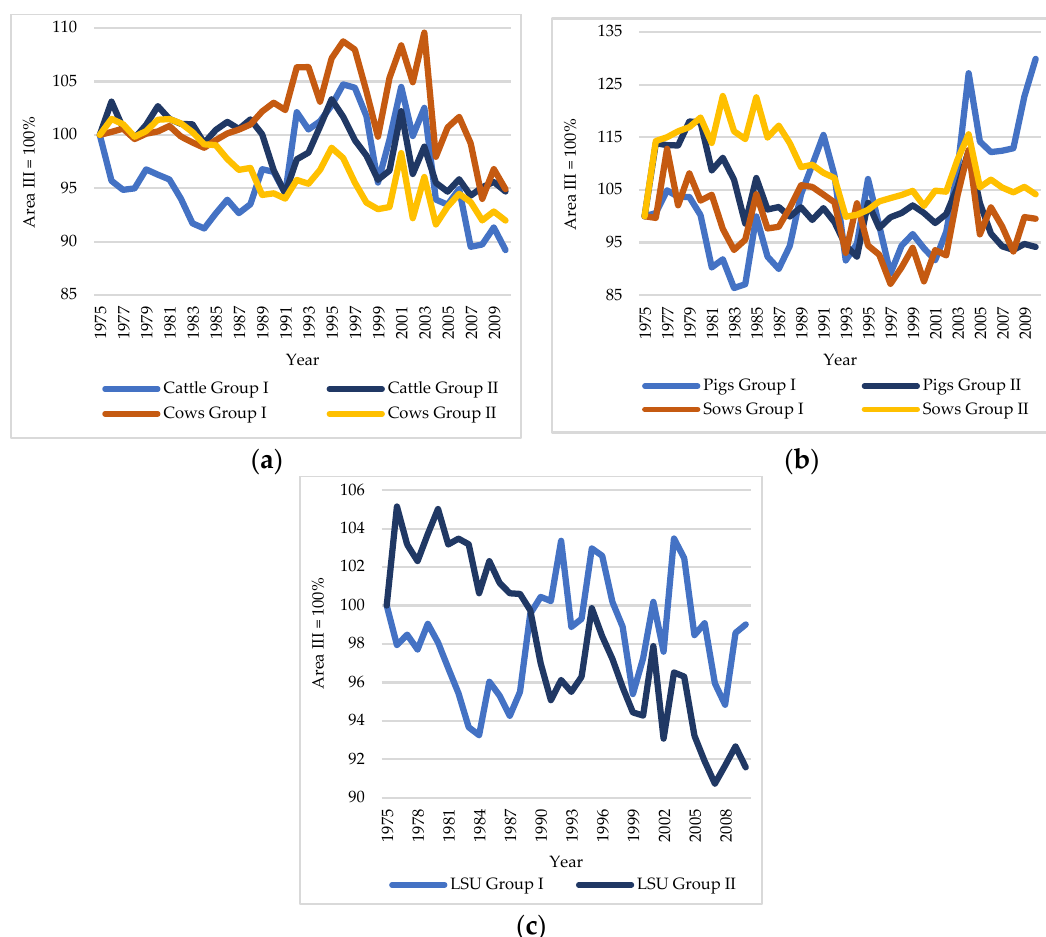
Figure 3. The dynamics of the livestock of cattle, cows, pigs, sows and the number of Large Size Units in Area I and II compared to the dynamics of the livestock in Area III for Bełchatów opencast mine (on the voivodship level): ( a ) cattle (without cows) and cows; ( b ) pigs (without sows) and sows; ( c ) large size unit (LSU). Source: based on [49–57].